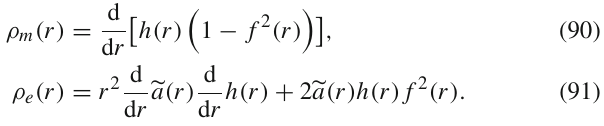
The charge densities ρ m ( r ) and ρ e ( r ) can be written in terms of the profile functions: